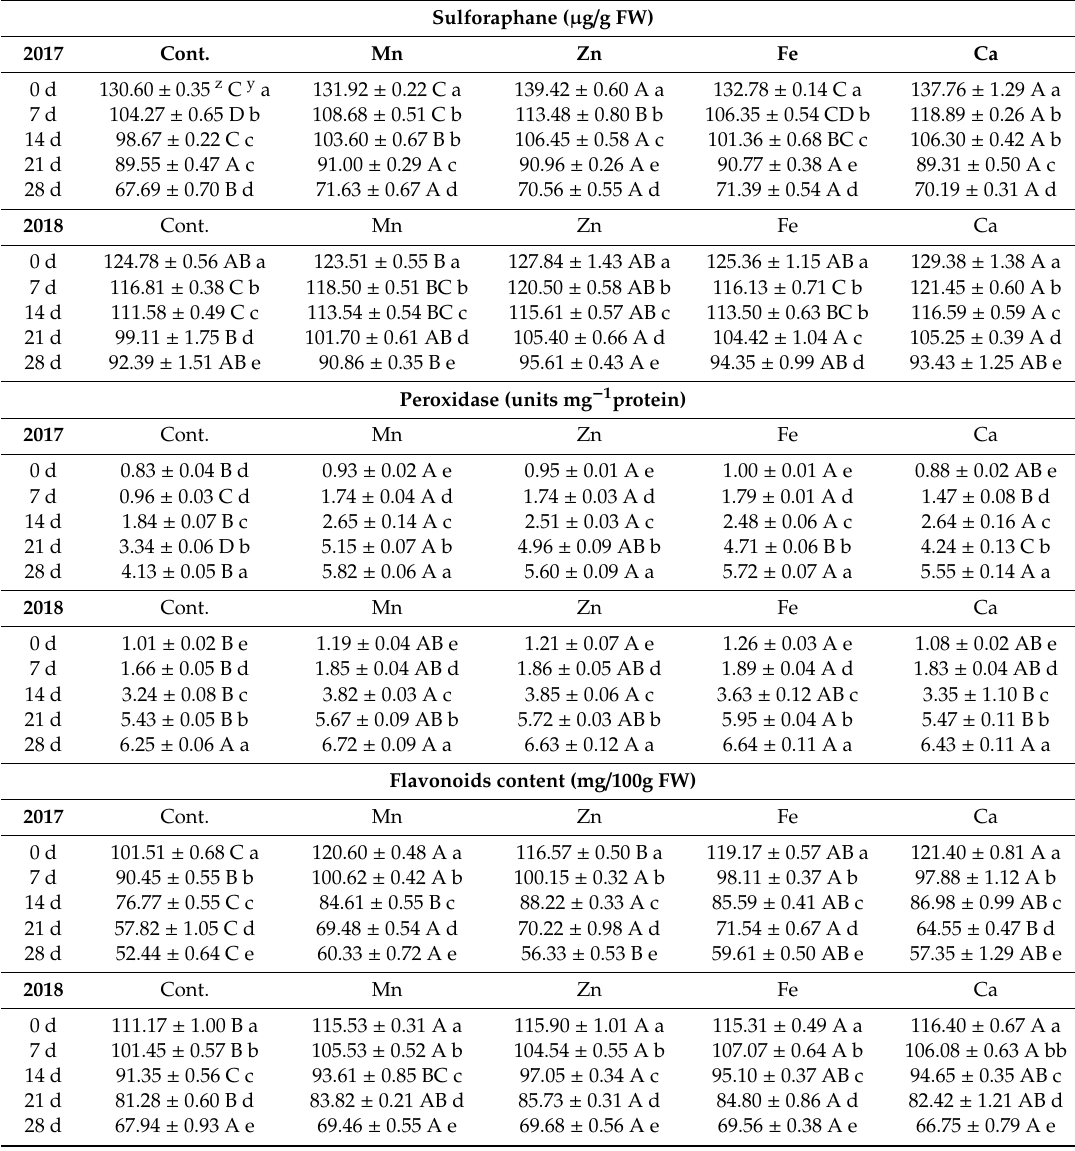
Table 5. E ff ect of foliar application of Ca, Mn, Zn, Fe elements plus water as the control on sulforaphane, peroxidase and flavonoids of broccoli florets stored for 28 days at 4 ◦ C. Sulforaphane ( µ g / g